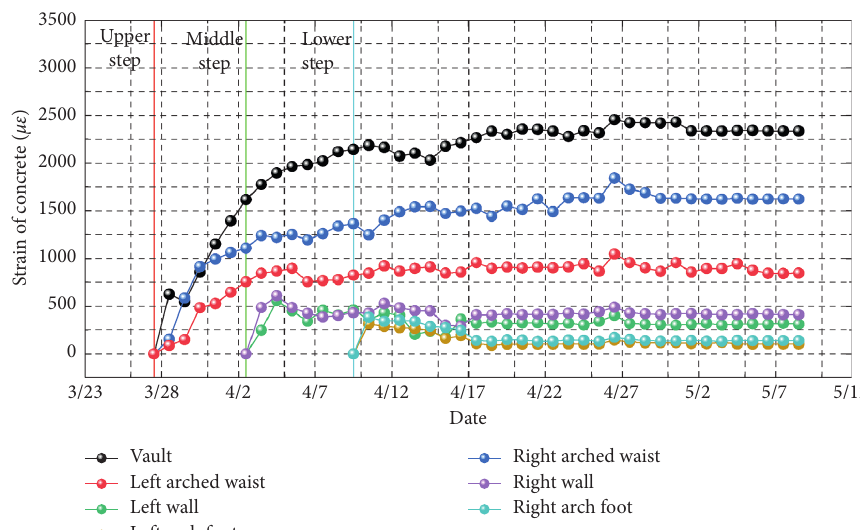
Figure 9: Strain of the concrete in section